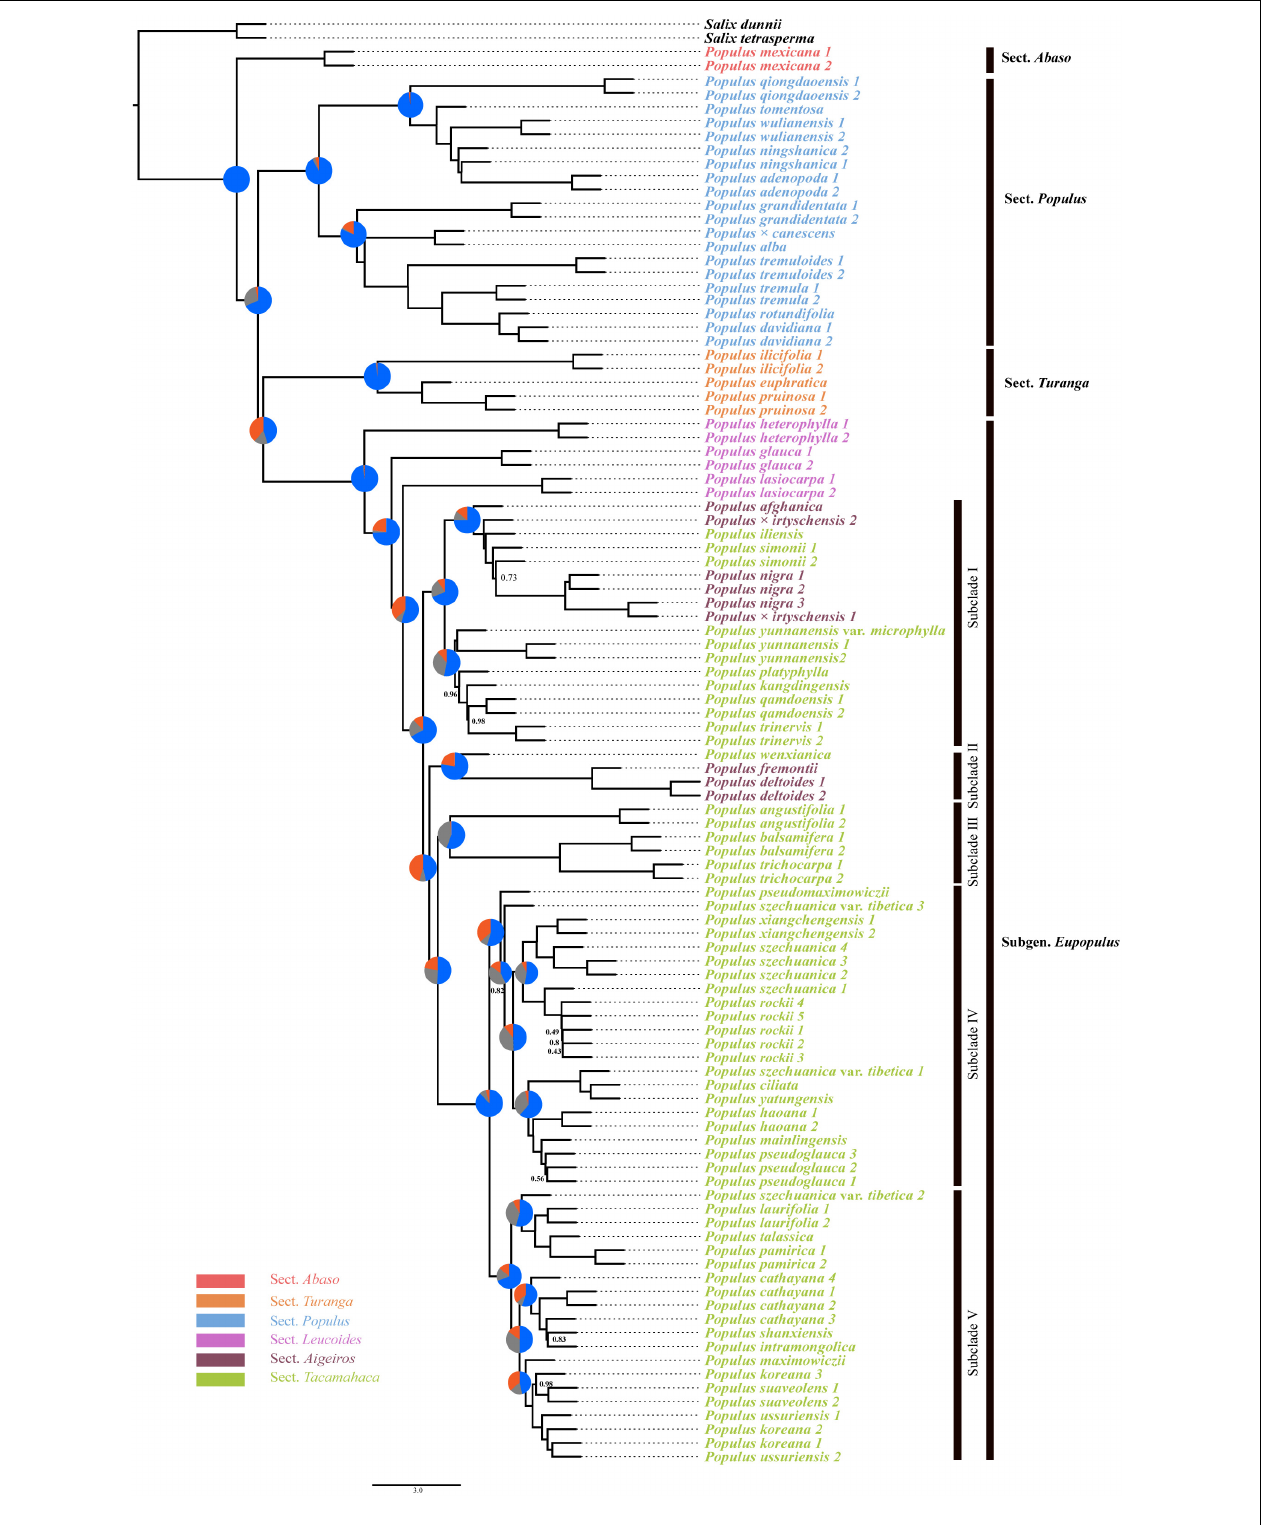
FIGURE 3 | Phylogeny estimated with alternative quartet topologies (-t 8) in ASTRAL based on 10 kb non-overlapping windows. Unless otherwise indicated, all nodes had 1.0 posterior probability. Pie charts present the quartet support for the main topology (blue), the first alternative (gray), and the second alternative (orange).